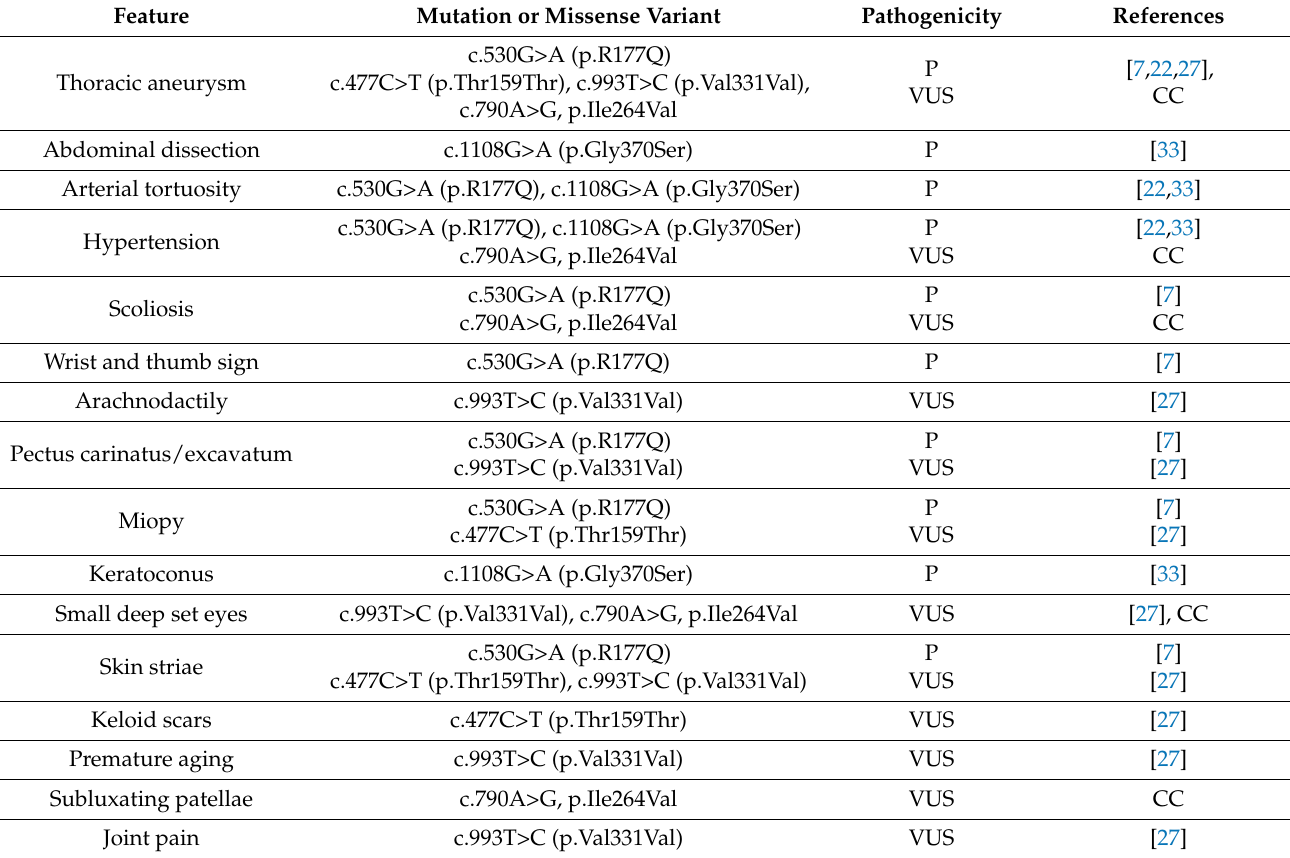
Table 1. Clinical features described in PRKG1 mutations or